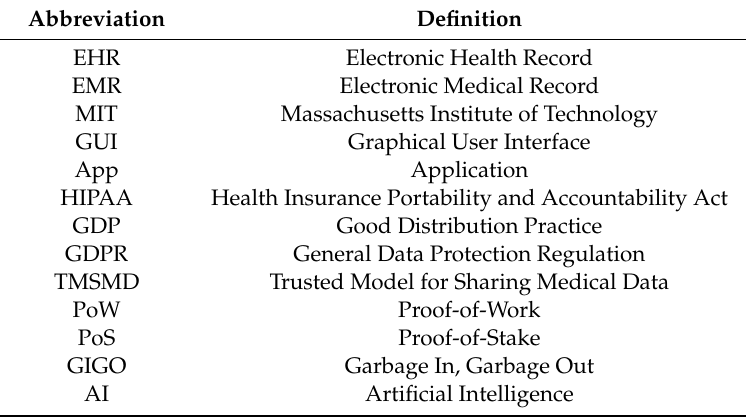
Table 1. Abbreviations and their